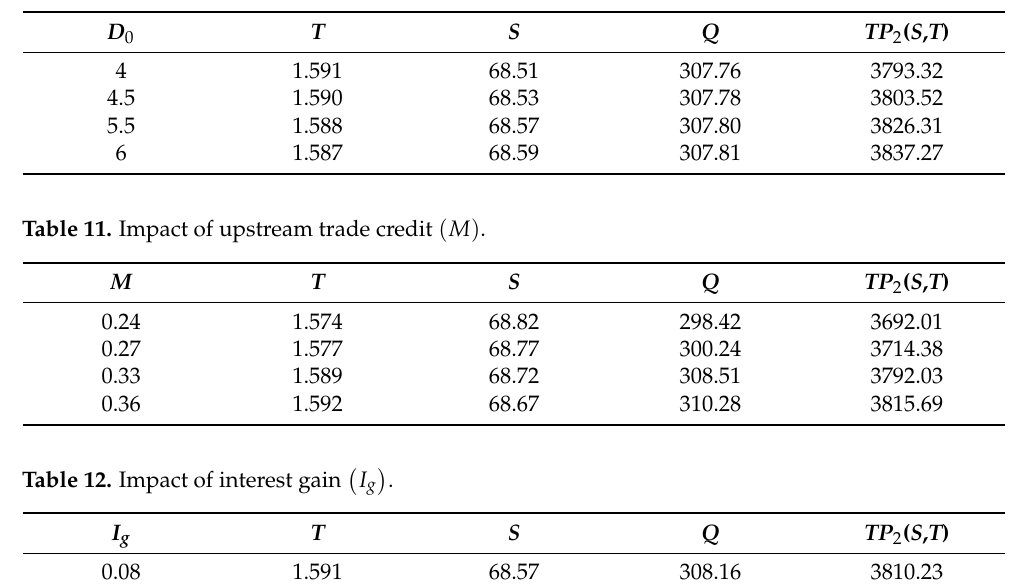
Table 10. Impact of initial rate of demand ( D 0 ) .